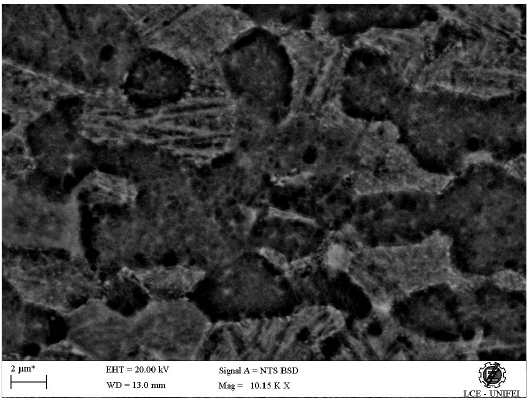
Figure 2. Annealed Ti-6Al-4V Microstructure.